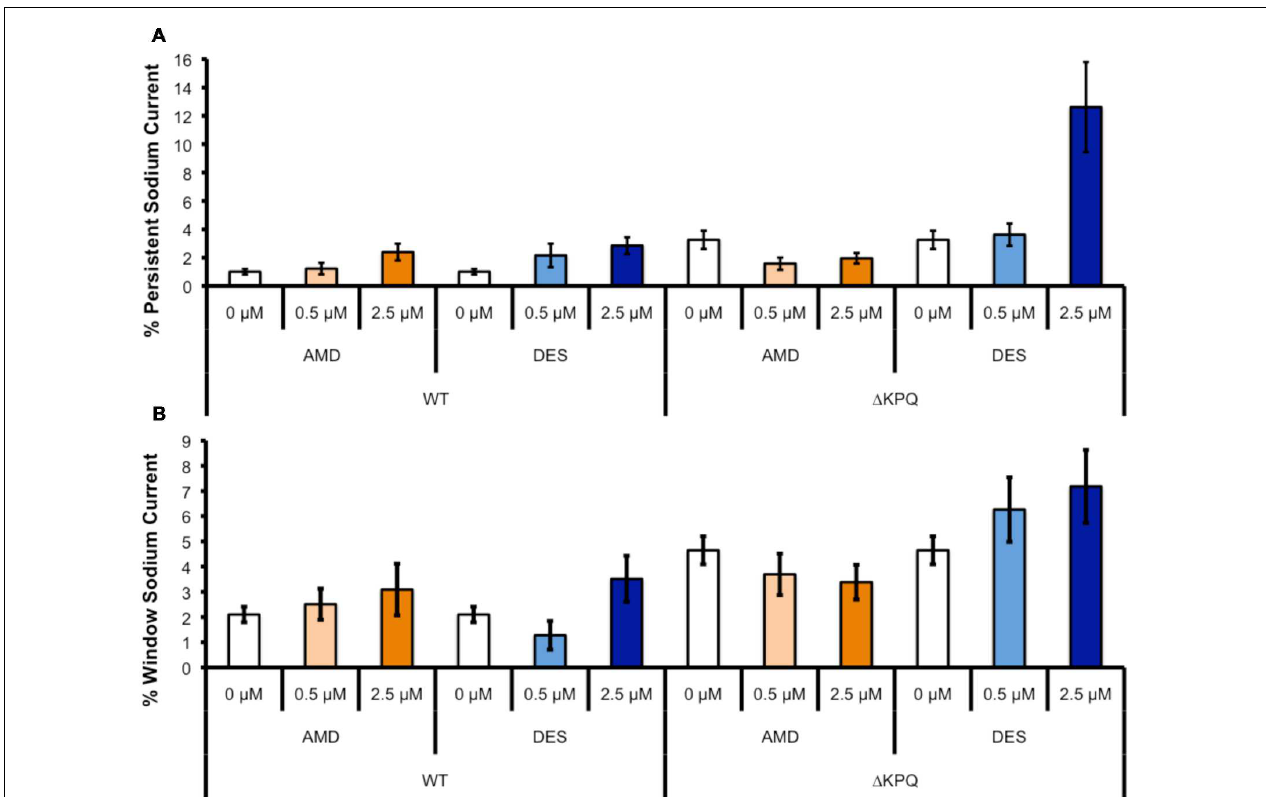
FIGURE 6 | (A) Shows the percentage of persistent sodium currents in either WT Na v 1.5 or (cid:49) KPQ channels after the perfusion of 0, 0.5, or 2.5 µ M AMD (light or dark orange) or DES (light or dark blue). (B) Shows the percentage of window sodium currents in either WT Na v 1.5 or (cid:49) KPQ channels after the perfusion of 0, 0.5, or 2.5 µ M AMD (light or dark orange) or DES (light or dark